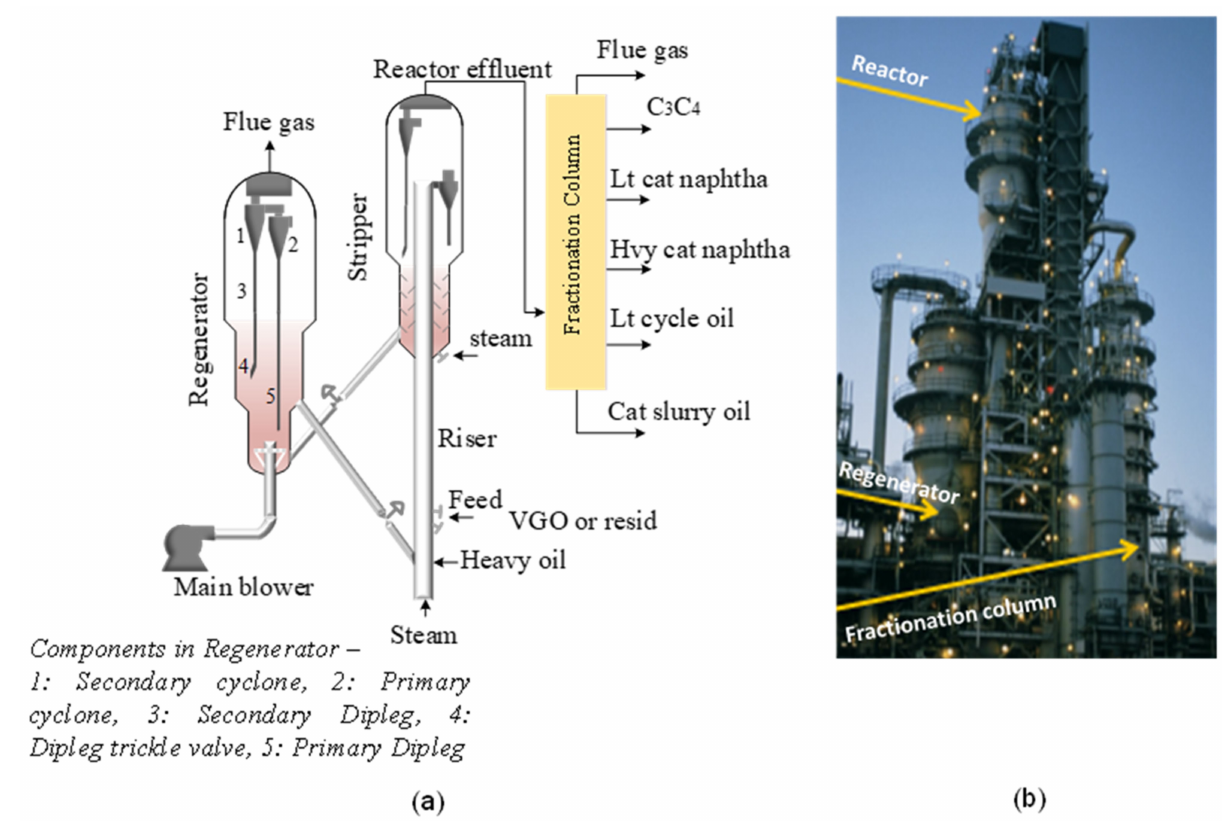
Figure 1. FCC unit. ( a ) Schematic diagram of a simplified set up; ( b ) industrial